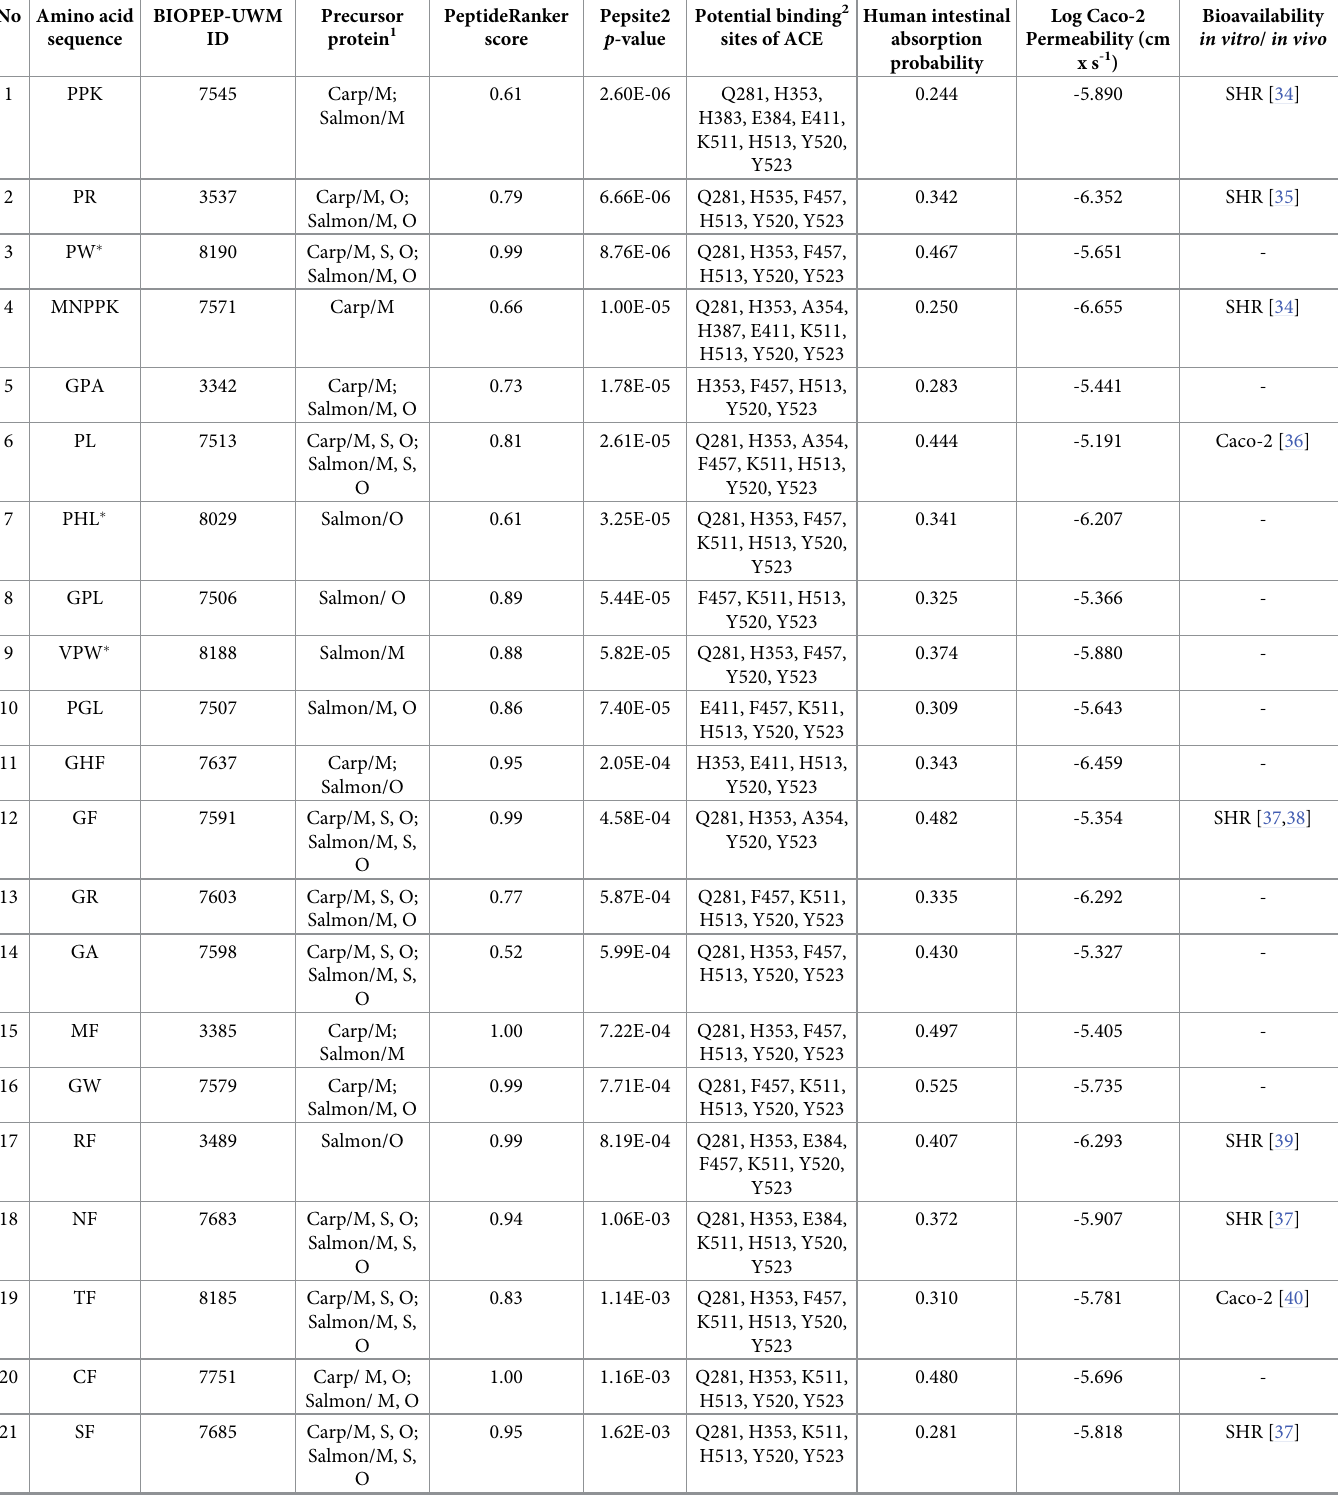
Table 3. The predicted amino acid sequences and properties of the most potentially active ACE inhibitory peptides and antioxidant ( � ) peptides matching the salmon and carp protein sequences after in silico -simulated human digestion. No Amino acid